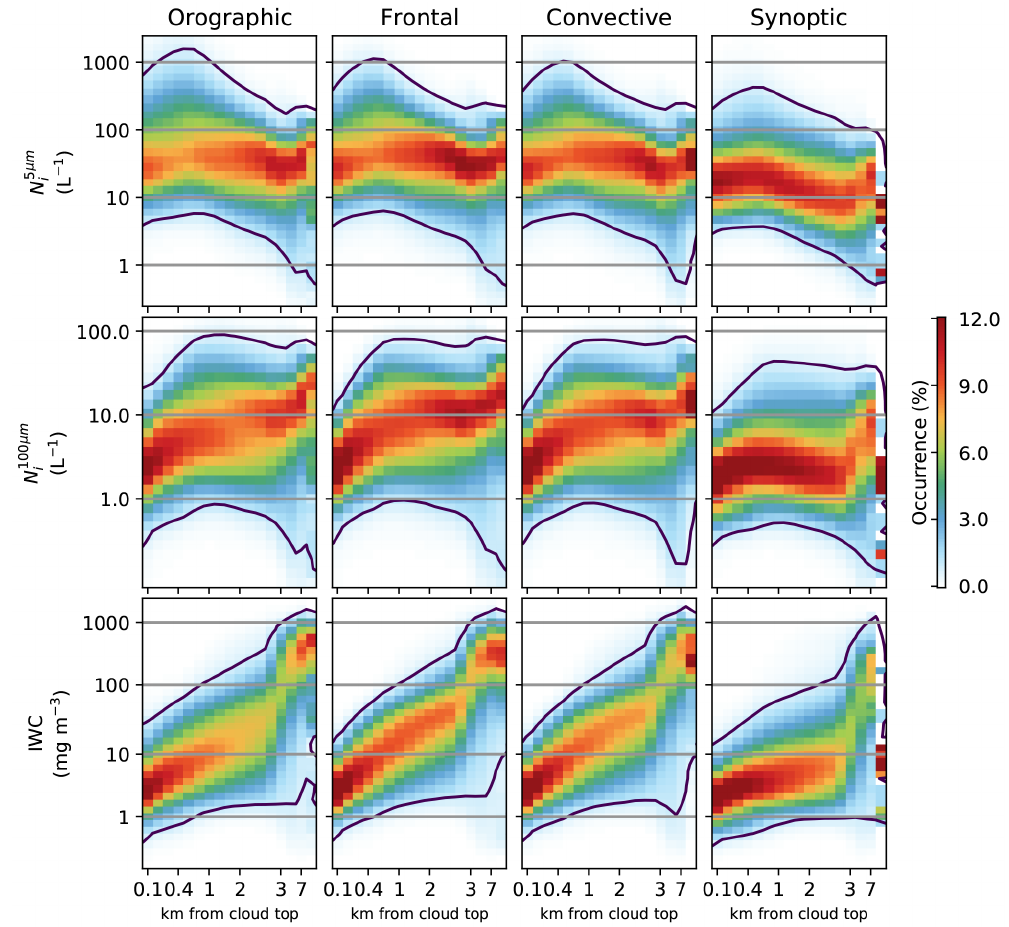
Figure 5. Retrieved properties as a function of the distance from the cloud top. This is for clouds with tops between − 40 and − 50 ◦ C. Note the nonlinear scale on the horizontal